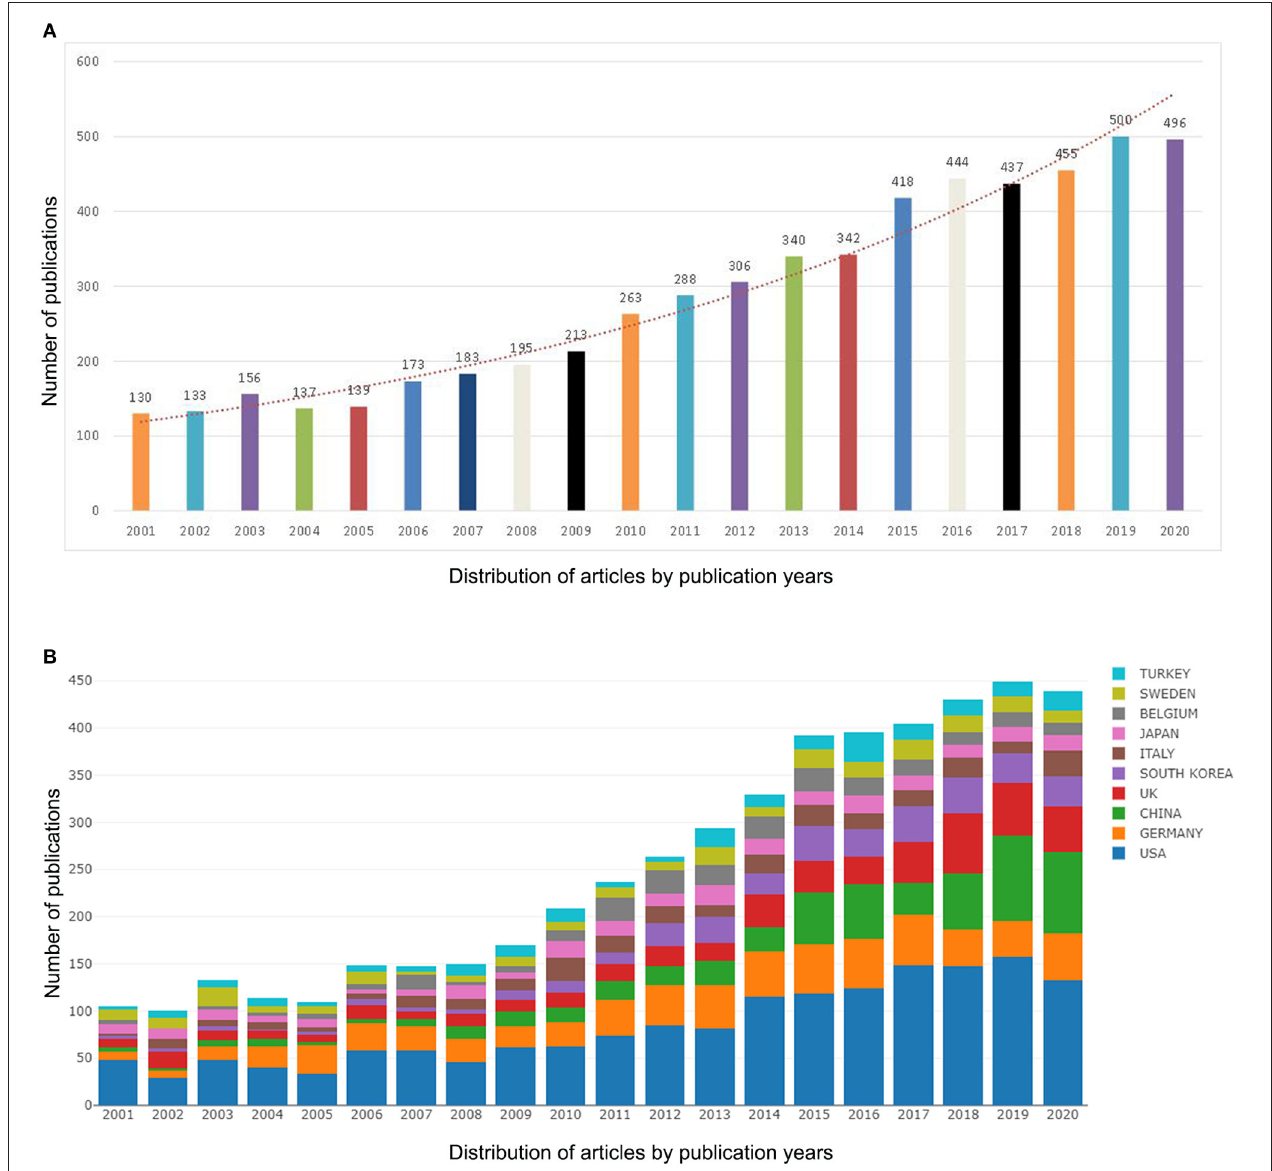
FIGURE 2 | Trends in the number of publications (A) and the top 10 countries/regions (B) on tinnitus research from 2001 to 2020.